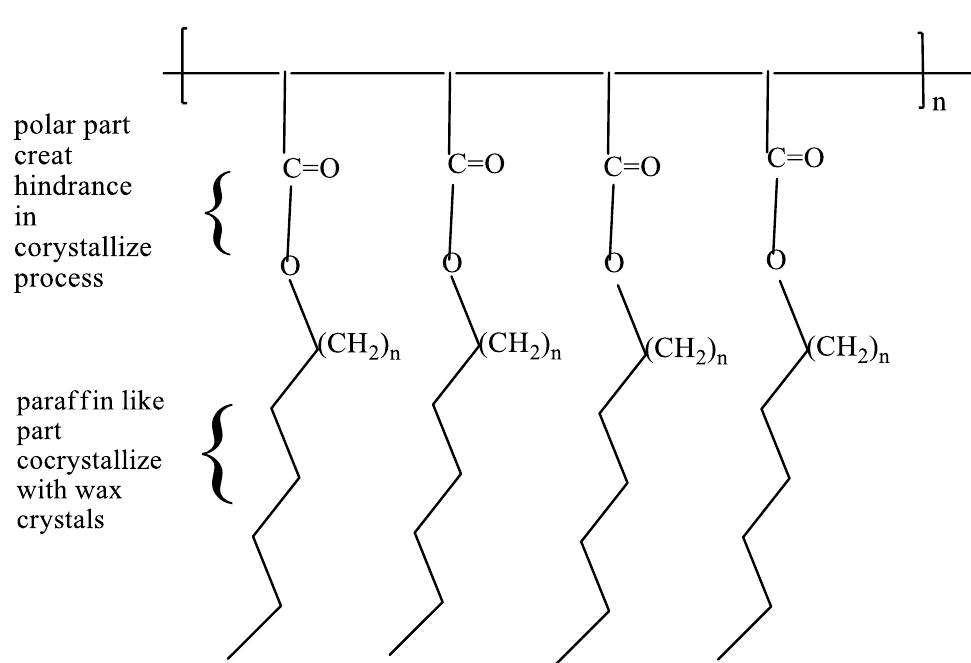
Figure 4. Comb polymer PPD structure with its distinguishing characteristics [34].